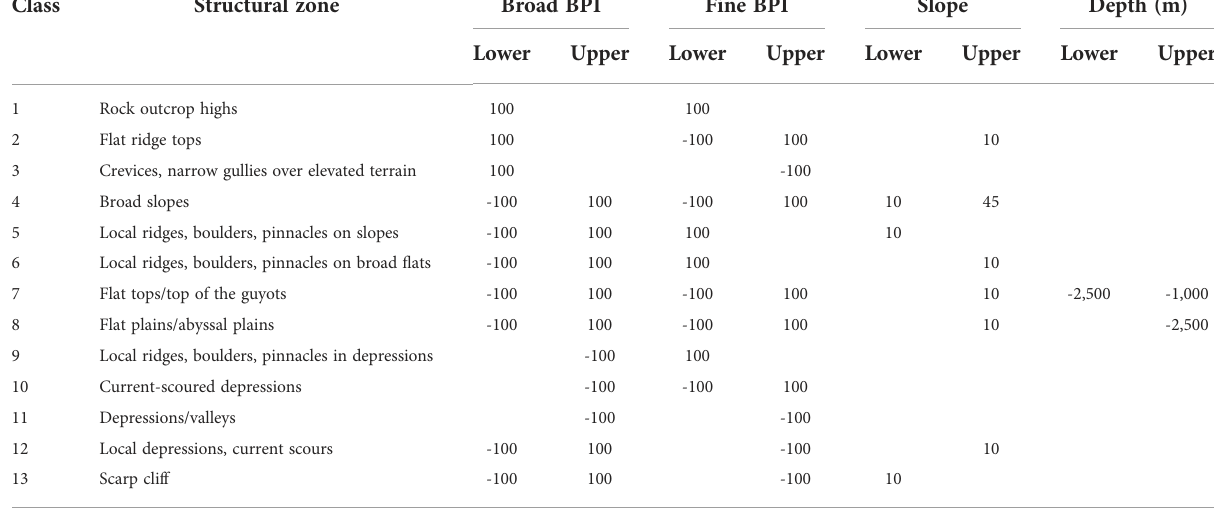
TABLE 2 Decision table of structures.